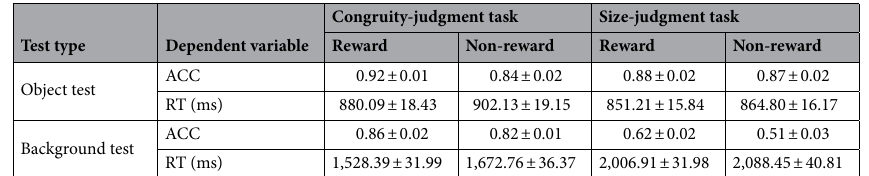
Table 2. Average ACC and RT of the test phases. The data after “ ± ” in the table are the standard errors of the mean.